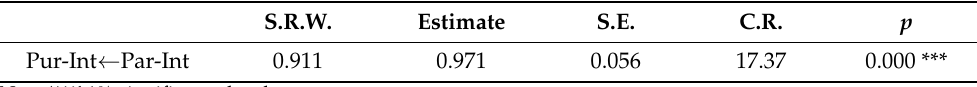
Table 4. Regression weights.